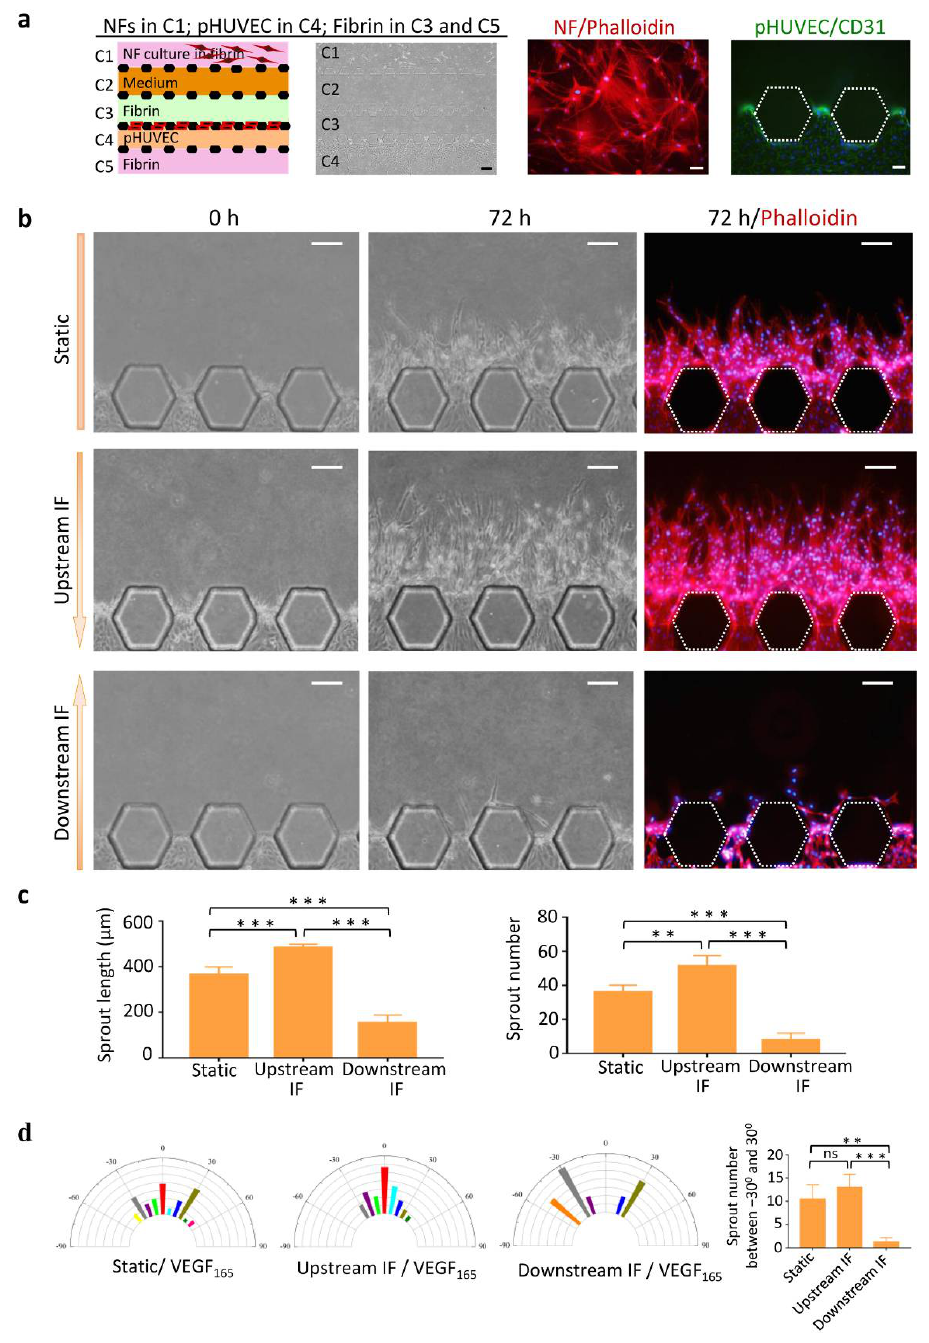
Figure 2. Effects of IF on angiogenesis induced by rVEGF 165 . ( a ) Cell seeding and fibrin loading in the chip. Illustration and bright field of cells and fibrin in individual channels (left). Scale bar = 200 µ m. Morphology of NFs in C1 stained with phalloidin (middle) and pHUVEC in C4 stained with CD31 (right). Scale bar = 50 µ m. ( b ) Images of vascular sprouts induced by rVEGF 165 (50 ng/mL) under the static (up panel), upstream IF (middle panel), and downstream (low panel) conditions. ( c ) Quantitative analyses of angiogenesis in terms of average sprout length and number. ( d ) Semicircular histograms showing the orientation angle distribution of the vascular sprouts in static (left), upstream IF (middle left), and downstream (middle right) conditions. Each Bar with different colors in the histograms represents the percentage of sprout orientation across the population of sprouts grown under the indicated condition. Orientation 0 represents the alignment of the sprout with the axis traversing channel C3. Quantitative analyses of sprout orientation (right). Scale bar = 100 µ m. ** p < 0.01, *** p <